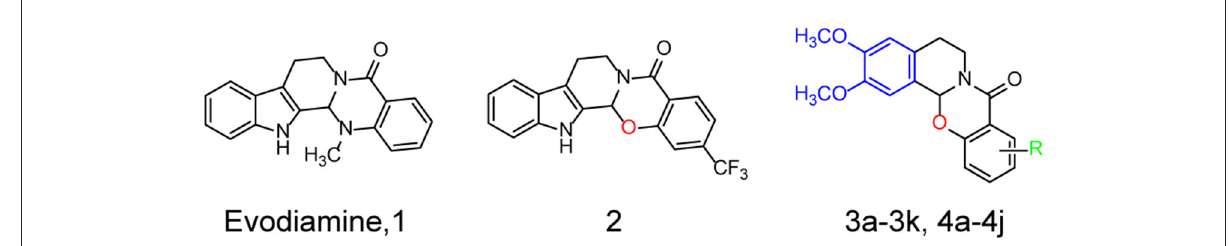
FIGURE1 Structures and the optimization strategies of evodiamine, 2 , and the target compounds.